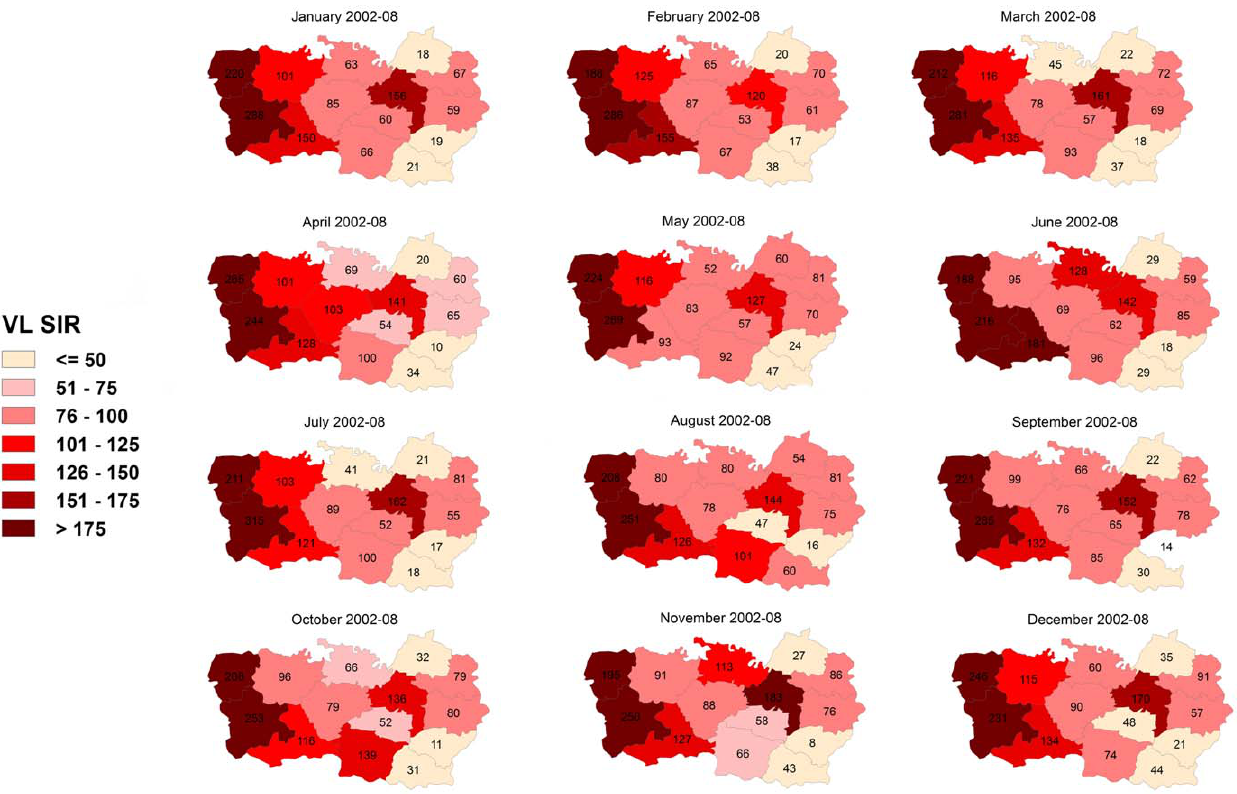
Figure 5. Visceral Leishmaniasis (VL) Standardised Incidence Ratio (SIR) per block and month in Muzzafarpur district in Bihar, India from 2002 to 2008. SIR was calculated per month using the VL incidence per month in all blocks as reference.